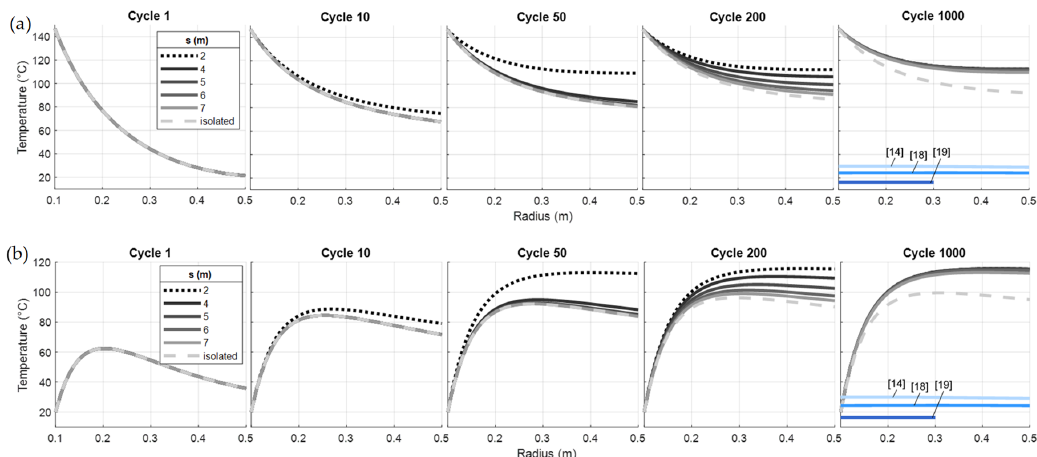
Figure 8. Distribution of the temperature along the radial direction in the 1st, 10th, 50th, 200th, and 1000th loading cycles at ( a ) 19:00 and ( b ) 7:00 (next day).